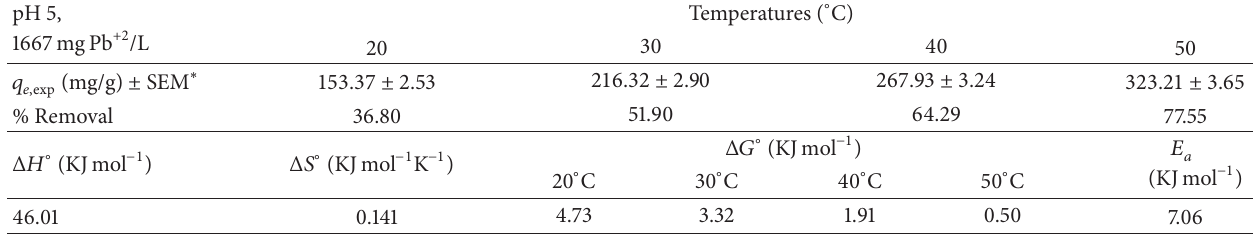
Table 7: Results of removal capacities at different temperatures and thermodynamic constants of Pb